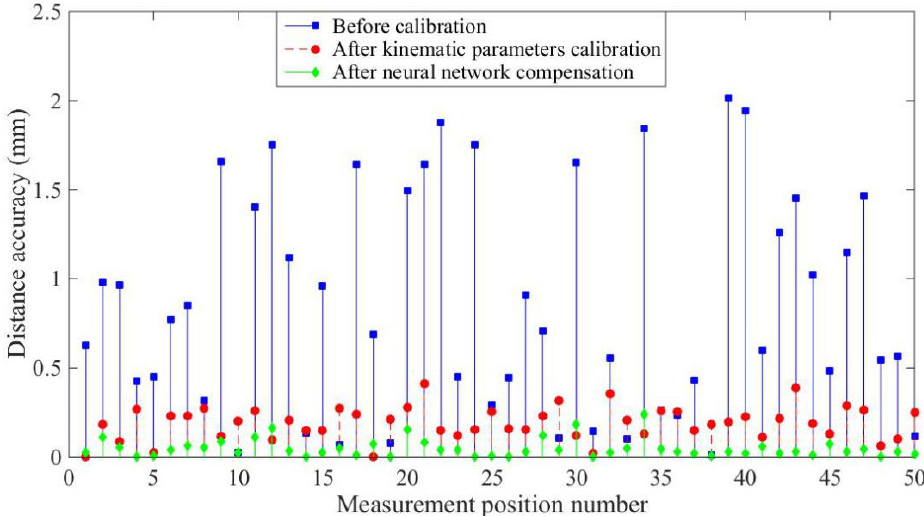
Figure 14. Distance accuracy of the experiments. Table 3. Positioning accuracy of the experiments.